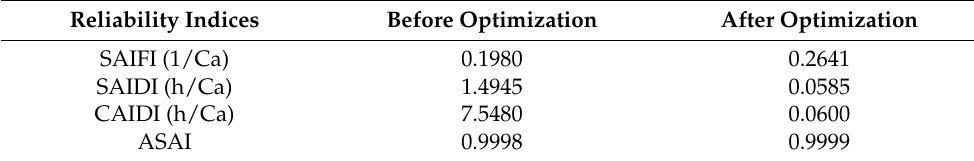
Table 11. Comparison of reliability indices before and after